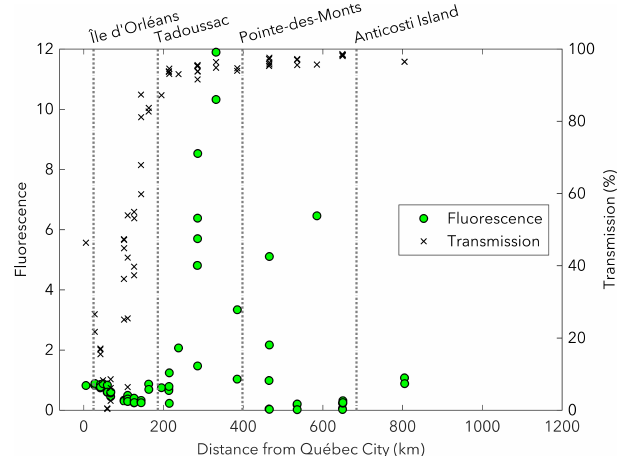
Figure 10. Spatial distributions of maximum fluorescence values (circles) and mean transmission values ( × symbols) in the euphotic zone of the St. Lawrence River, SLE, and GSL during the May 2016 cruise. Fluorescence is a primary production proxy, whereas trans- mission is an excellent proxy for turbidity (low transmission values are due to light absorption by suspended particulate matter and/or colored dissolved organic